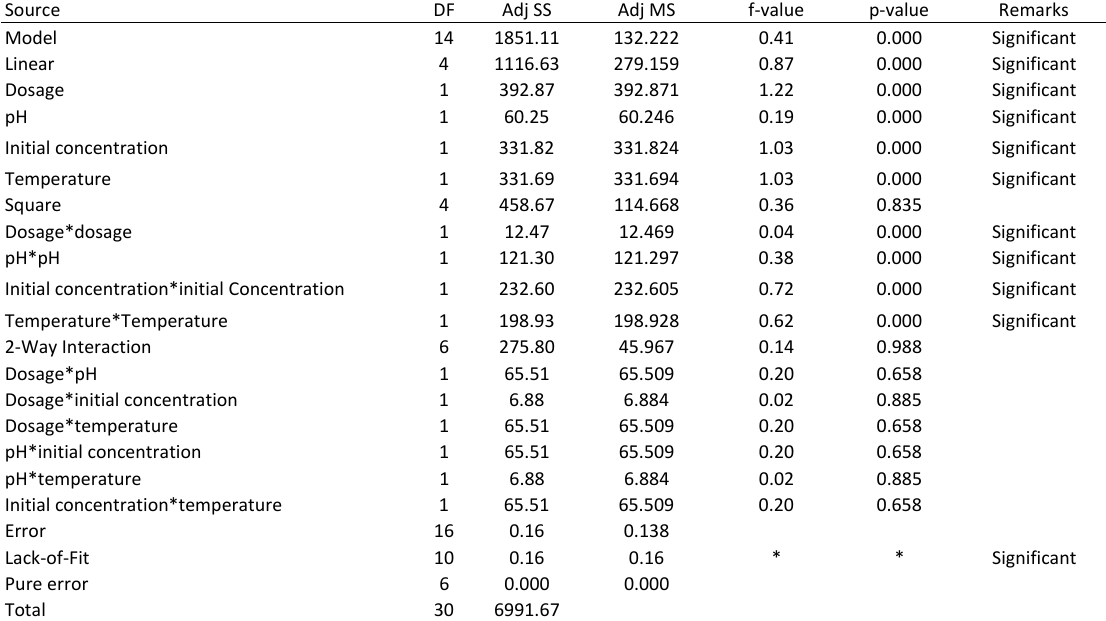
Table 2: Analysis of variance (ANOVA) for batch adsorption process